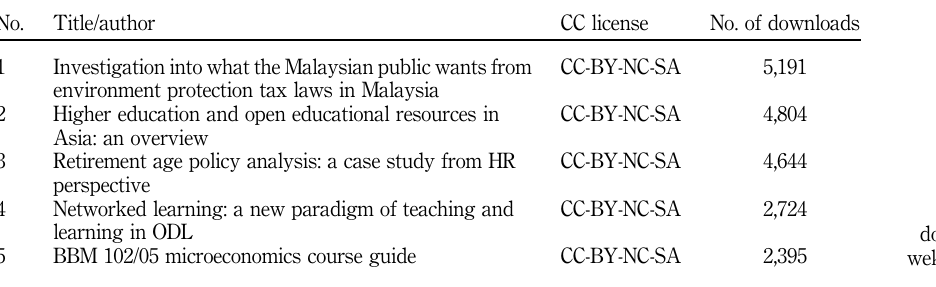
Figure 4. Web access usage statistics of weko.